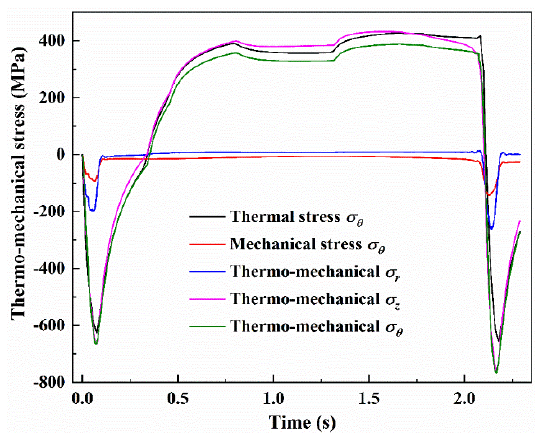
Figure 7. Thermo-mechanical stress components in radial, circumferential and axial directions at the roll surface comparing with thermal stress and pure mechanical stress.